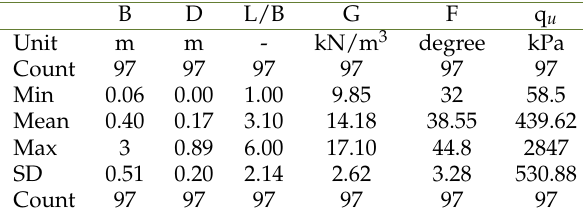
Table 1. Statistics of the data used in the study